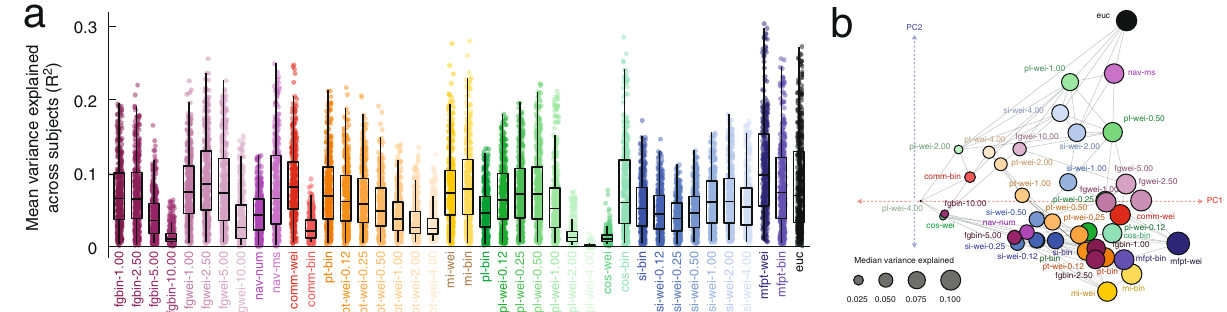
Fig. 2 Explaining regional FC patterns with dynamic, topological, and geometric factors. a Distributions of variance explained by different factors. Points represent brain regions and the mean variance explained across the entire cohort. Each point represents a subject ( N sub = 70 subjects following exclusion for motion and data quality; FC and SC averaged over two scan sessions). In each boxplot, the “ box ” denotes interquartile range (IQR), the horizontal bar indicates the median value, and the whiskers include points that are within 1.5 × IQR of upper and lower bounds of the IQR (25th and 7th percentiles). Any points that fall beyond the whiskers are, by convention, considered outliers. b Spatial embedding of predictors. The coordinates were determined using the following procedure: 1) calculating the similarity of regional correlations for every pair of predictors, 2) thresholding this matrix to retain the k = 4 nearest neighbors for each predictor, and 3) performing a principal component analysis of the thresholded and symmetrized matrix. Coordinates represent the fi rst two principal components, PC1 and PC2. Broadly, predictors that are near/distant to one another in principal component space exhibit similar/dissimilar patterns of regional correlations. In this plot, edges exist between predictors if they are nearest neighbors. Note that here the principal component analysis was carried out without z-scoring or centering the columns of the correlation matrix. The size of points is proportional to the mean variance explained across all brain regions. Source data are provided as a Source Data fi